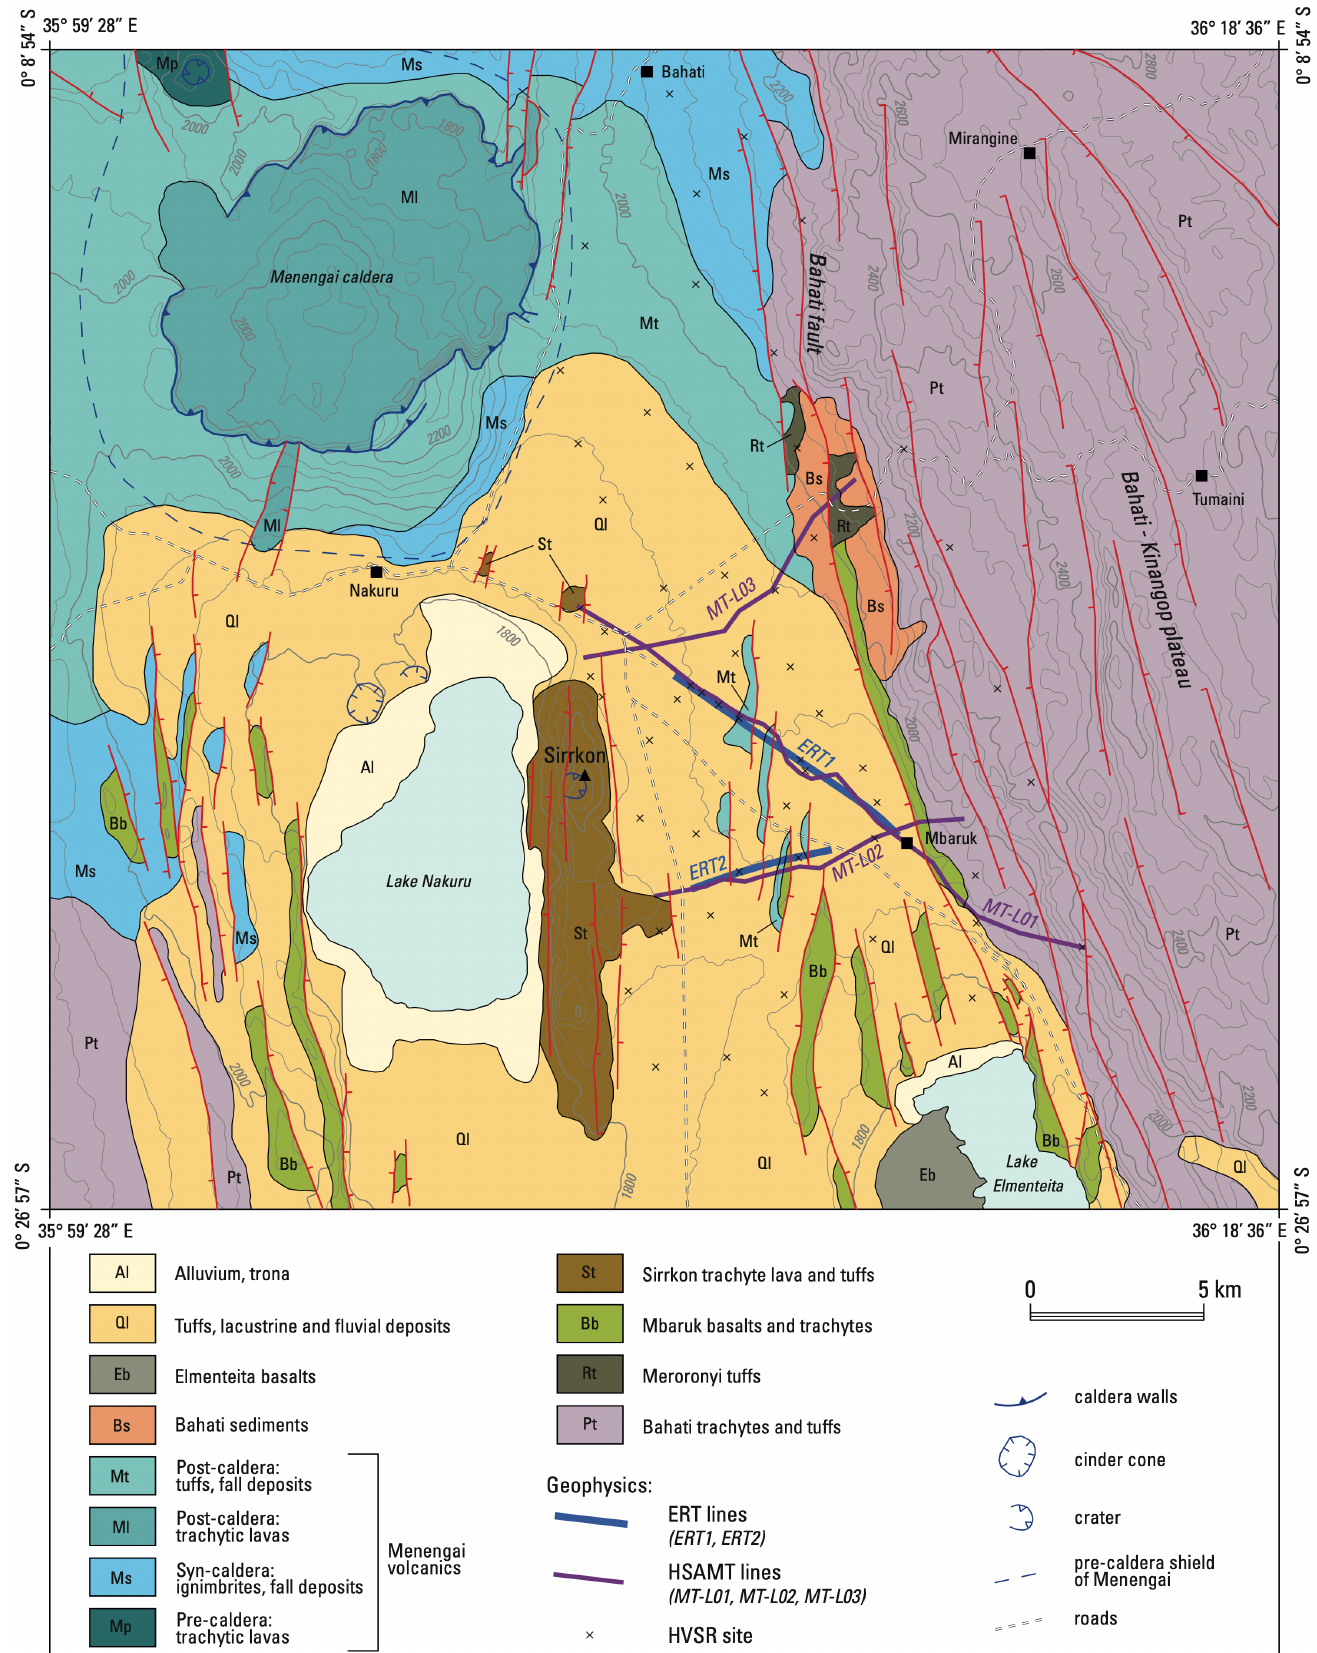
Figure 5. Geological map of the Nakuru area, after Leat [25], McCall [31], Leat [45] and original field